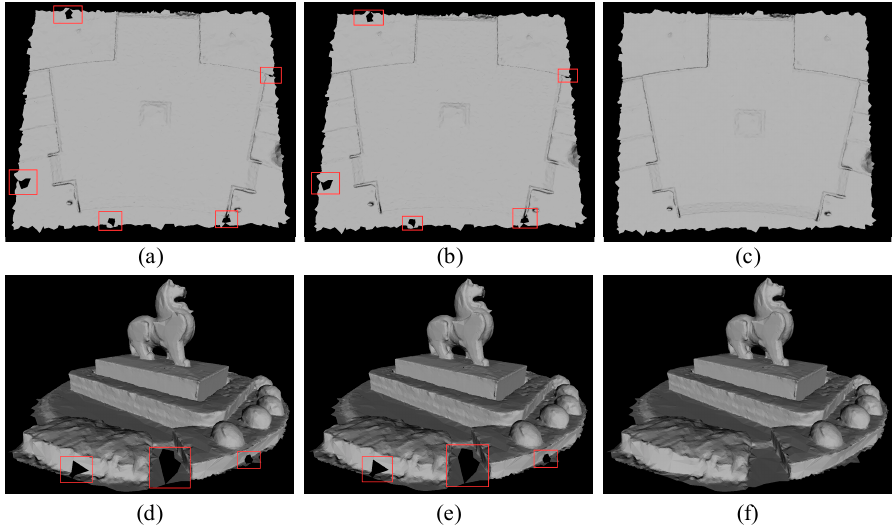
Figure 9. The holes filling results of the model with holes: (a) and (d) are the results of VCG; (b) and (e) are the results of MeshFix; the red box indicates the boundary holes that were not detected; the corresponding boundary holes are detected and repaired in the proposed LIMOFilling shown in (c) and (f).